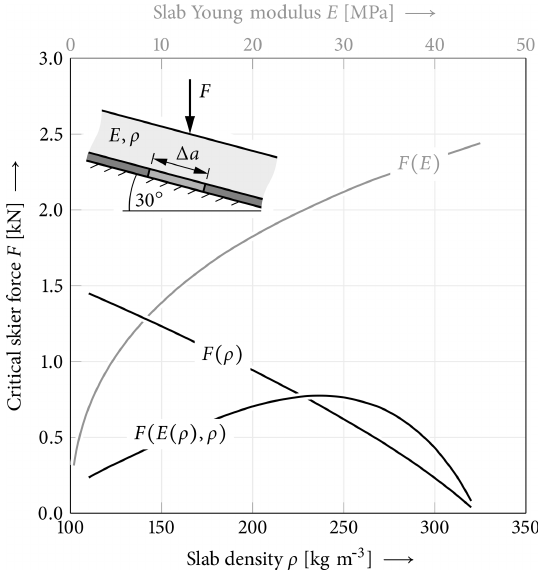
Figure 7. Effect of slab density ρ on critical skier force F of a defect-free snowpack and the corresponding length of the initiated crack (cid:49)a . If the slab’s Young modulus is independent of slab den- sity, curve F(ρ) , the increasing slab weight reduces the critical skier force. A density-dependent Young modulus according to Eq. (22), curve F(E(ρ),ρ) , stiffens denser slabs, which initially dominates failure and increases the critical skier load. Above a certain thresh- old, the weight gain becomes dominant and the critical skier force reduces